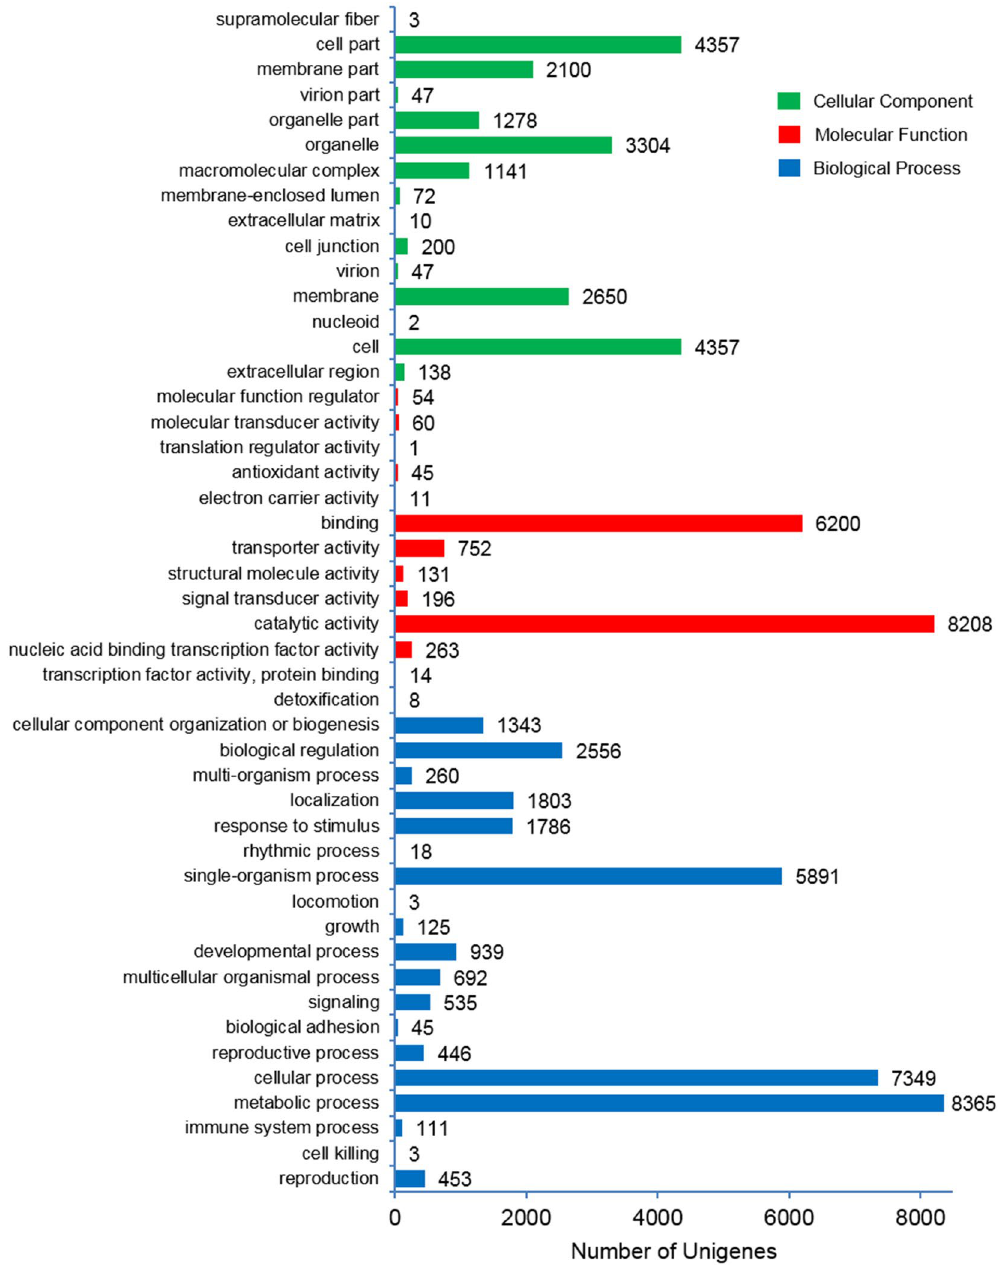
Figure 3. Histogram of Gene Ontology (GO) assignments for transcriptome sequences of sacha inchi seeds; the unigenes corresponded to three main categories: biological processes (blue bars); cellular components (green bars); and, molecular functions (red bars), with the length of each bar (and numbers at the tail of each bar) indicating the number of unigenes in each